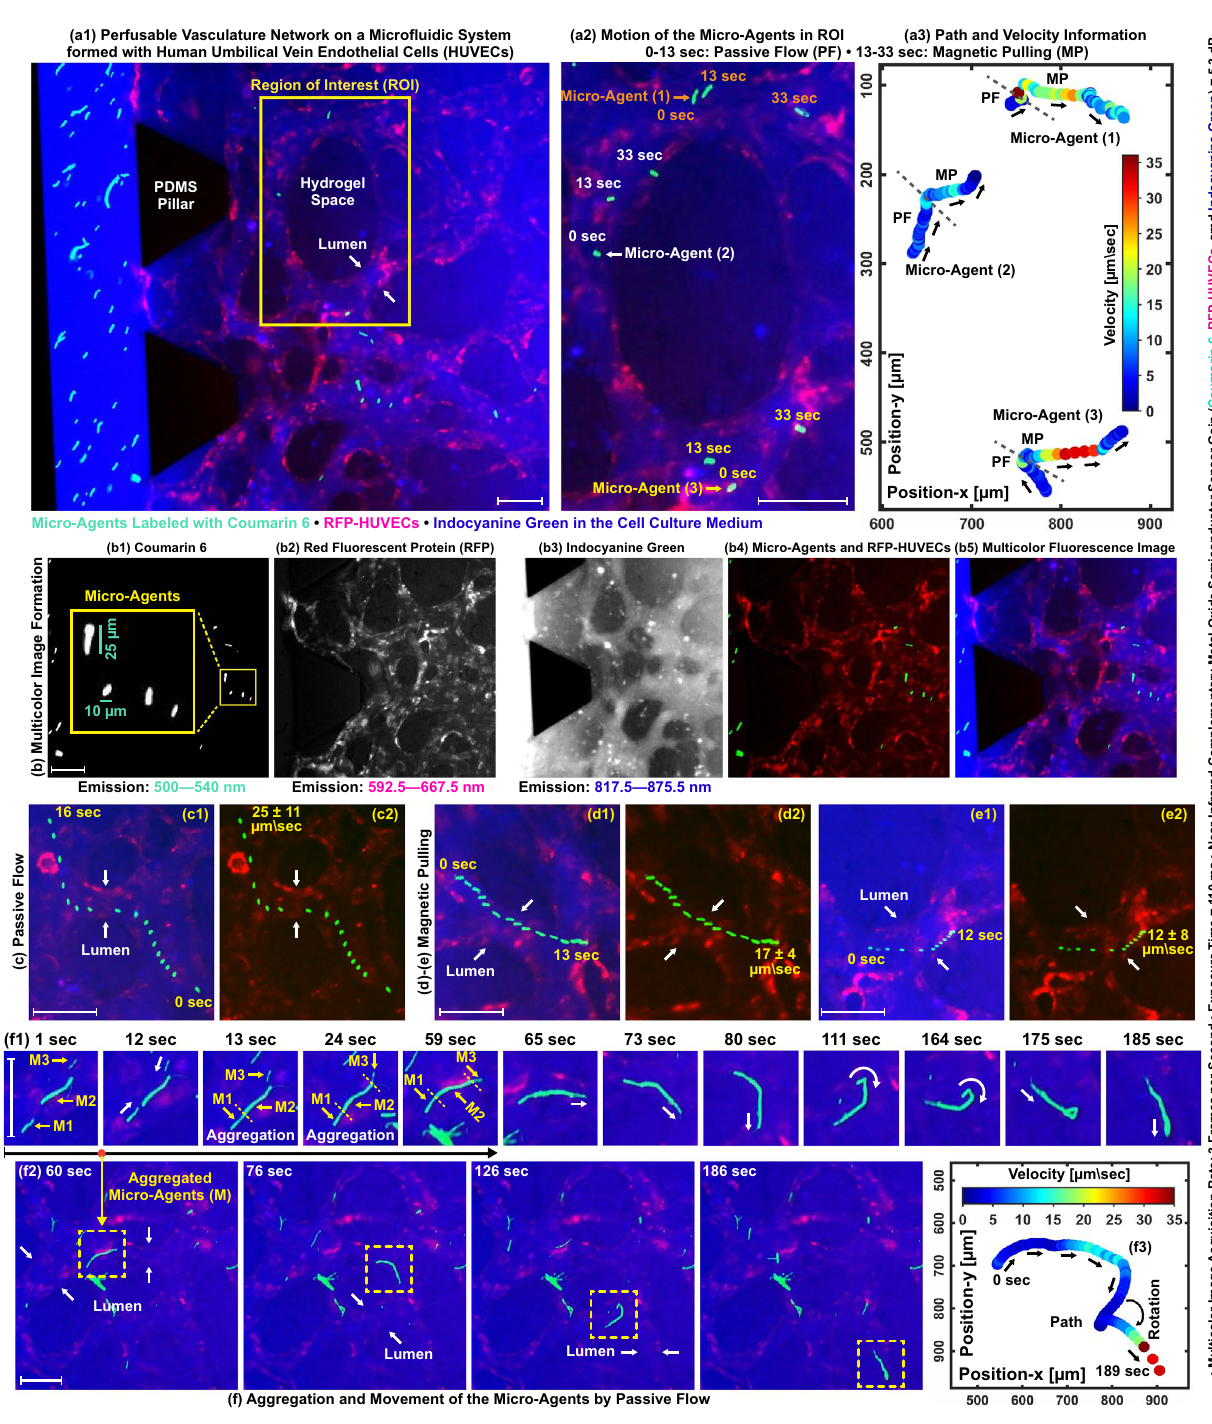
Figure 7. Multicolor fluorescence microscopy for visualizing the magnetic micro-agents in a perfusable vasculature network. ( a1 ) Multicolor image of the micro-agents labeled with coumarin 6 in a